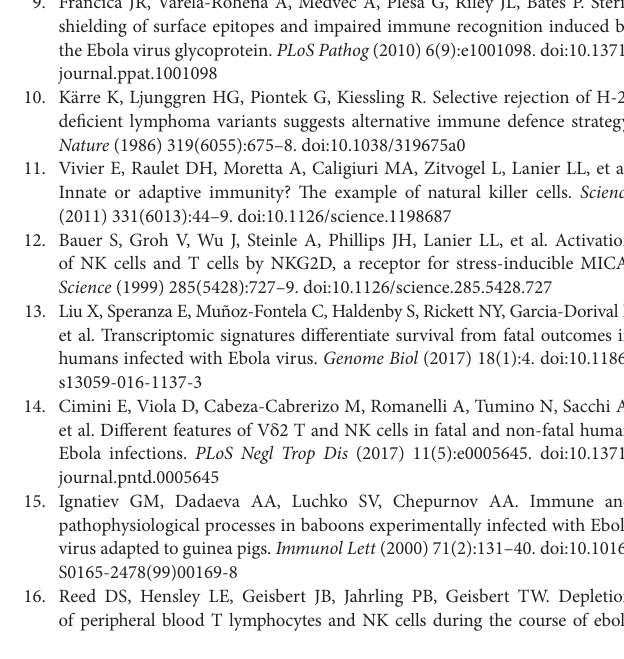
FigUre s5 | Glycoprotein-mediated downmodulation of pNK activation from different donors. (a) CD107a FACS-based degranulation assay was performed as previously described, results from four different donors are depicted. (B) IFN γ ELISA-based cytokine secretion assay was performed as previously described, results from four different donors are depicted. Results are from one representative experiment of two performed. (c) CD107a FACS-based degranulation assay, including KIRR2DL2 staining, was performed as previously described, results from four different donors are depicted. Values represent means of triplicates. Bars, ± SD. FigUre s6 | Co incubation of pNK cell with GP expressing cell does not affect NCR expression nor the expression of NKG2D and KIR2DL2. HEK293T cells were either SUDV-GP transfected or mock transfected and cocultured with pNK cells in the presence of 25 U/ml rhIL2. Cells were then harvested and pNK cells were analyzed for NKr expression by flow cytometry. Dead cells were excluded by 7-aminoactinomycin D; pNK cells were then gated by staining for CD16 and co-stained for either NKp30, NKp44, NKp46, NKG2D, or